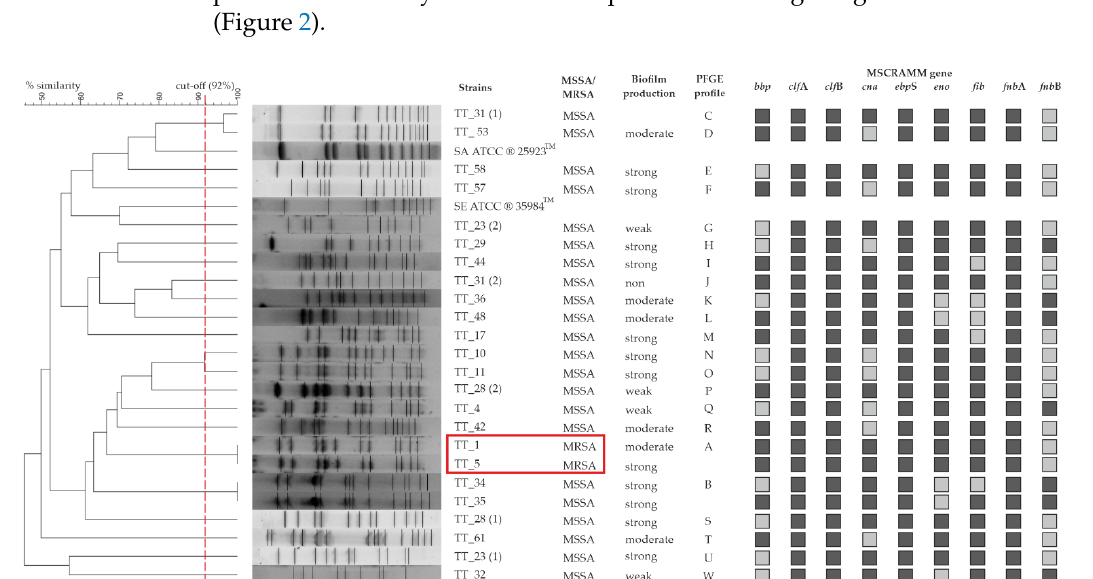
Figure 3. Biofilm–forming ability of S. aureus strains isolated from tracheostomy tubes.